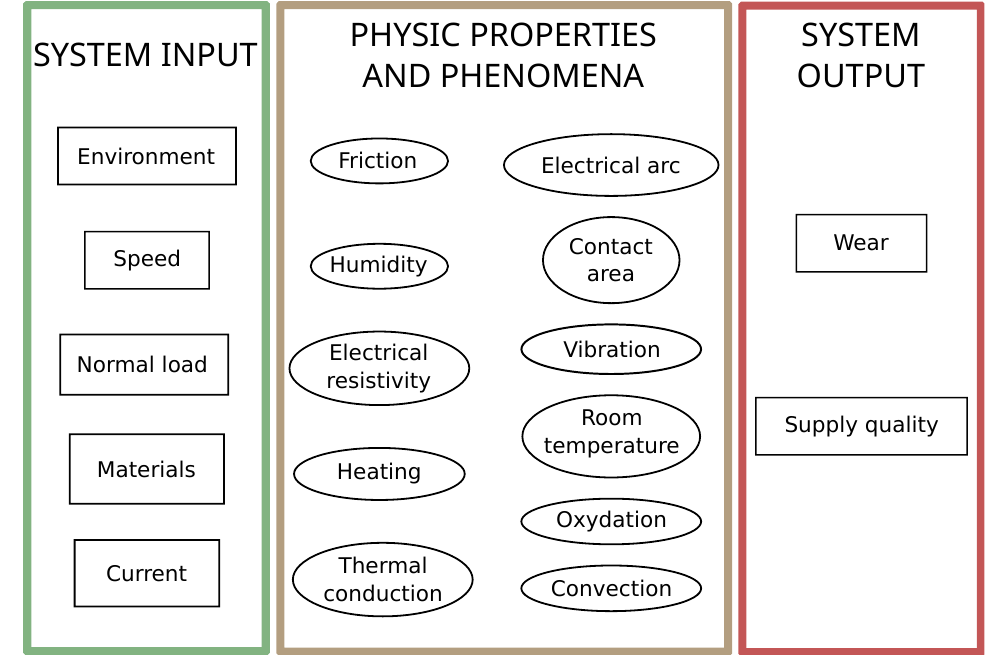
Figure 2. Description of the parameters of a sliding electrical